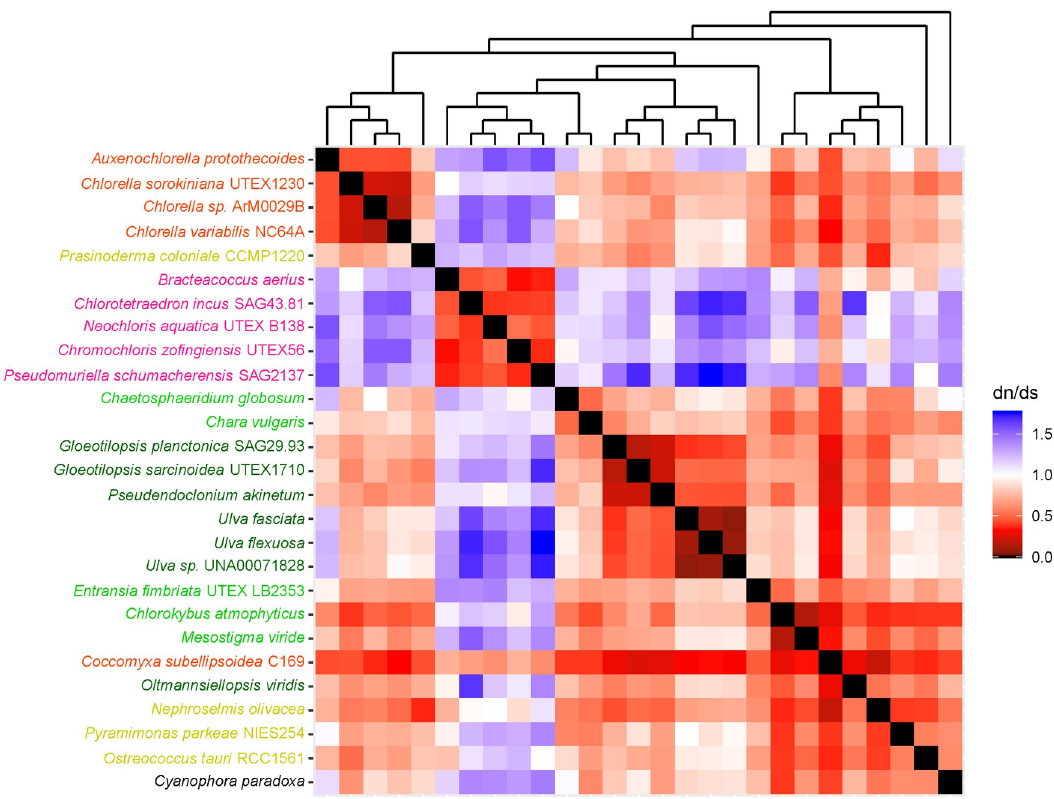
Fig 7. Heatmap of pairwise dN/dSdn/ds ratios calculated from alignment of plastid rps 3. The scale bar represents color corresponding to pairwise dN/dS ratios. The cladogram above the heatmap corresponds to phylogenetic relationship estimated using algal rps